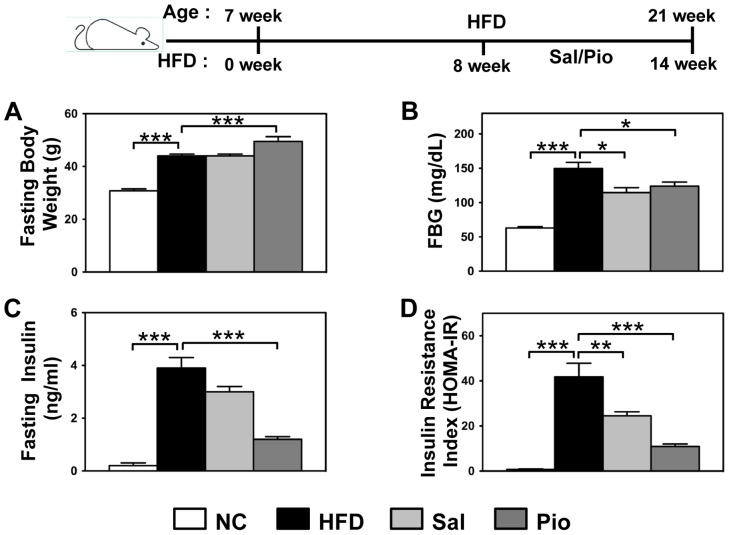
Treatment with Pio and/or Sal improves HFD-induced insulin resistance.C57BL/6 male mice (n = 8 per group) were given a HFD starting at 7 weeks of age. After 8 weeks on HFD, the animals were fed for another 6 weeks with HFD alone or HFD plus salicylates (Sal, 3 g/kg diet) or Pioglitazone (Pio, 100 mg/kg diet). The mice fed NC served as a control. After overnight fasting, the metabolic phenotypes were measured. The fasting body weight (A), fasting blood glucose levels (B), fasting serum insulin levels (C), and the insulin resistance index as HOMA-IR (D) are shown. *p<0.05; **p<0.01; ***p<0.001.